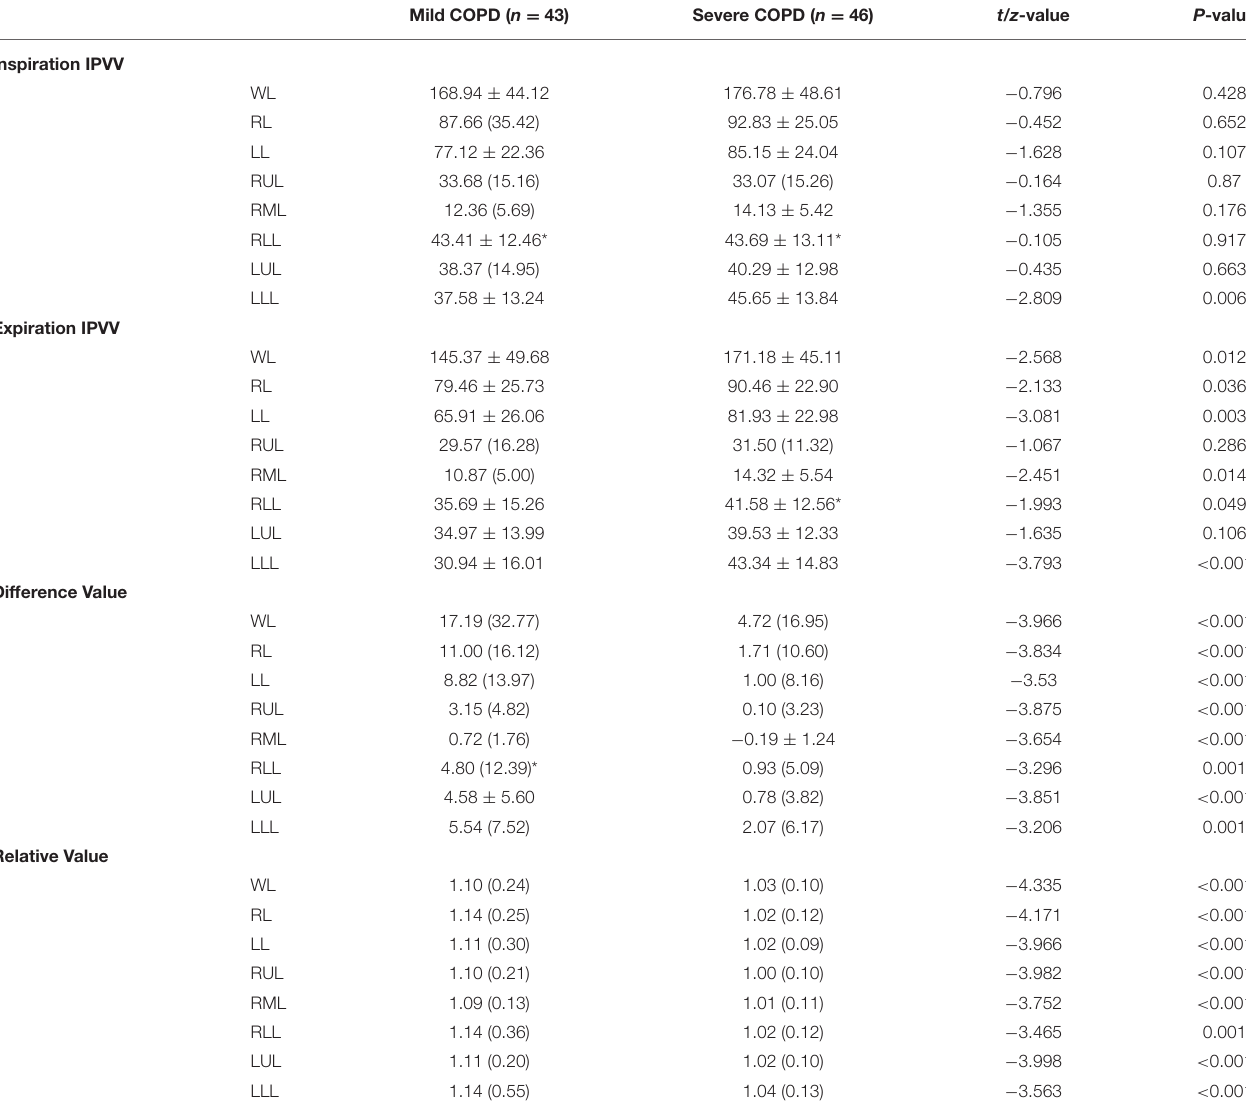
TABLE 2 | Comparisons of IPVV between mild and severe COPD. Mild COPD ( n = 43) Severe COPD ( n =